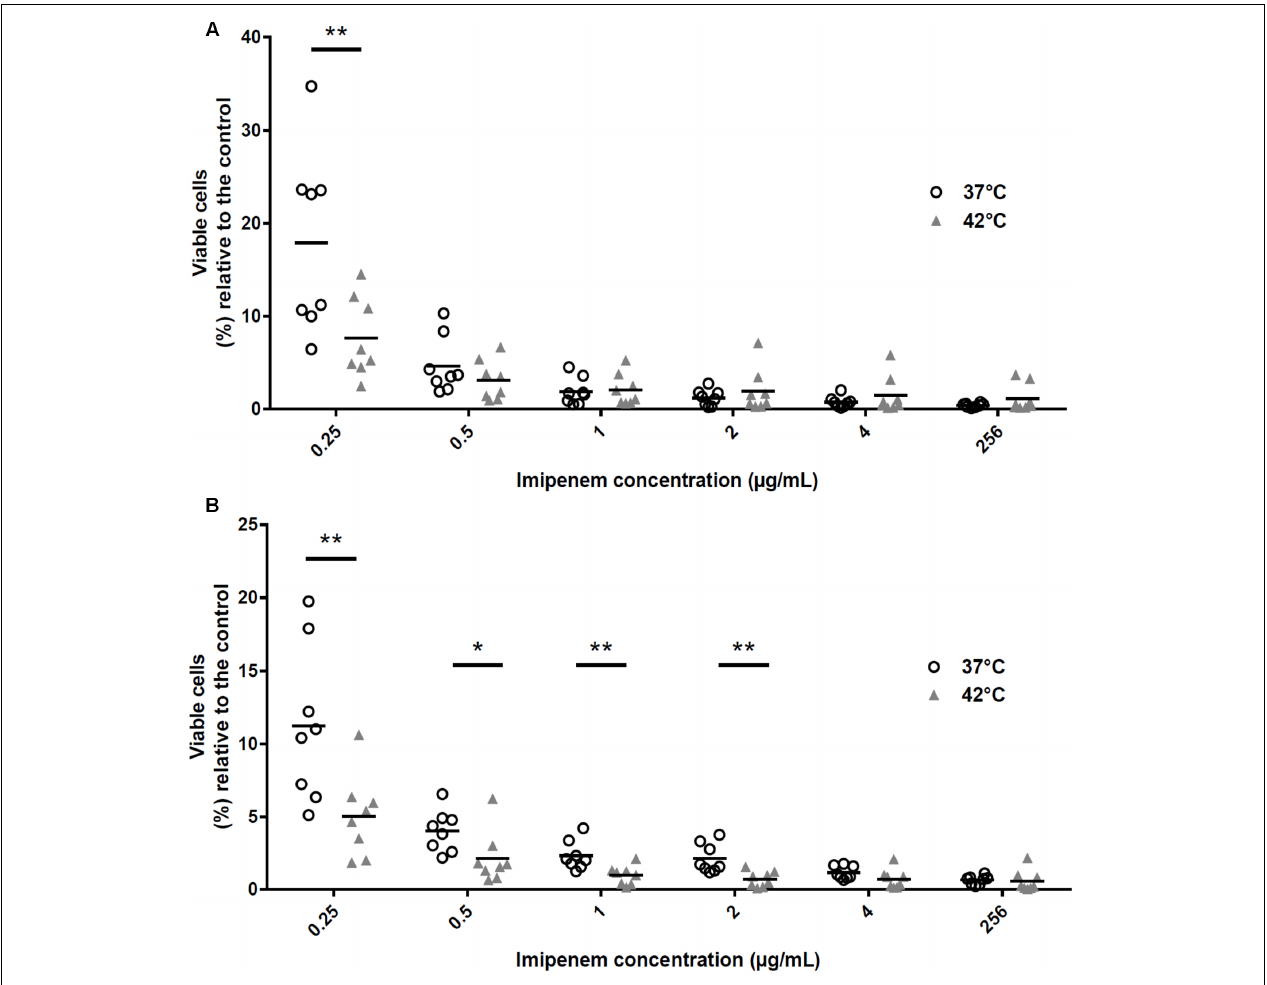
FIGURE 3 | Percentage of viable NTHi cells relative to the control condition after exposition to increasing concentration of imipenem during 3 h at either 37 or 42 ◦ C. The amounts of GE47 and GE88 viable cells after incubation with increasing concentration of imipenem ranged from 0.25 to 256 µ g/mL at either 37 or 42 ◦ C were normalized based on their amount of viable cells in a control condition (i.e., growth at either 37 or 42 ◦ C with 0 µ g/mL of imipenem). No significant difference was observed on viable cells between 37 and 42 ◦ C when the bacterial cells were incubated with higher imipenem concentrations ( > 0.25 µ g/mL for GE47 and > 2.0 µ g/mL for GE88) (Supplementary Figure S4). (A) GE47 strain (imipenem MIC by E-test = > 32 µ g/mL); (B) GE88 strain (imipenem MIC by E-test = > 32 µ g/mL). Experiments were performed in eight independent biological replicates. ∗ p < 0.05, ∗∗ p < 0.01 (paired Student’s t